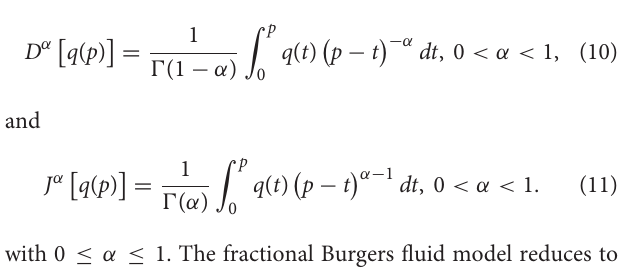
FIGURE 1 | Schematic view of the inclined tube with cilia.